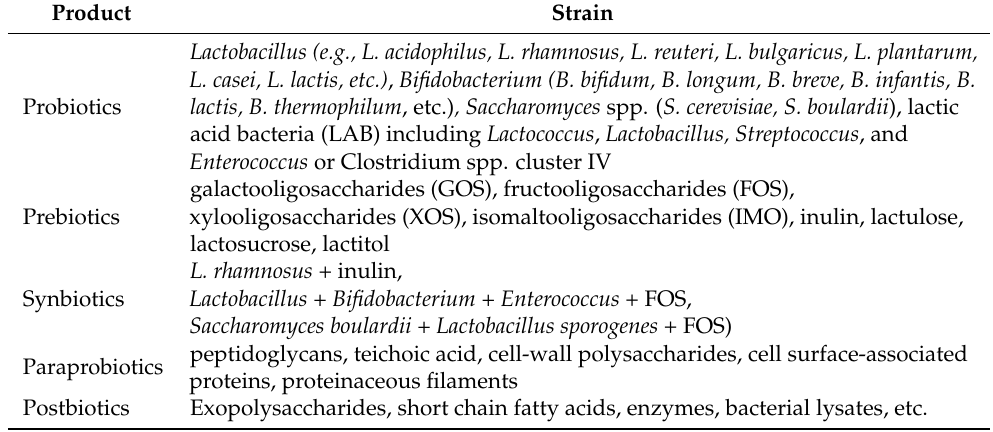
Table 2. Examples of supplements [53–55].